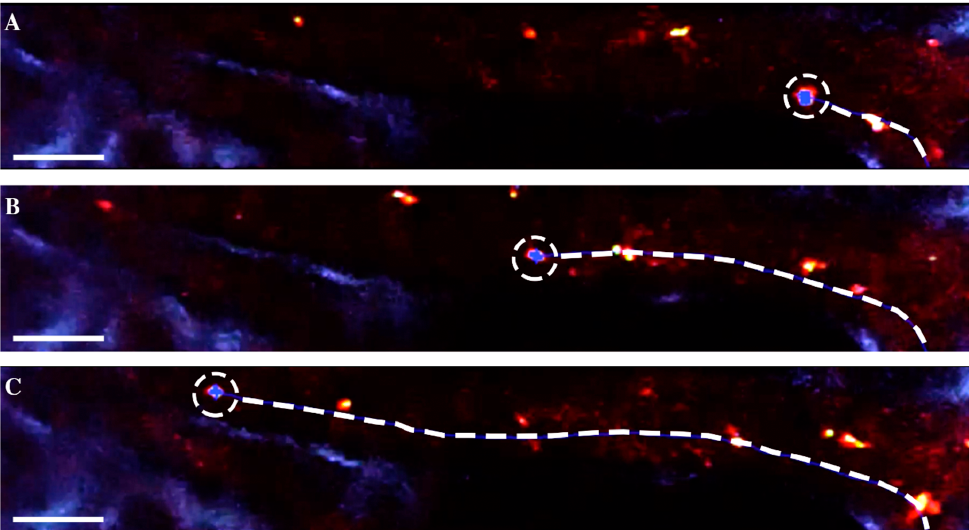
Figure 4. Sample particle tracking of an individual gold–silica nanoparticle within vasculature. ( A – C ) Nanoparticles are identified through the co-registration of luminescence in three imaging channels: 446, 525, and 575 nm. The nanoparticle is position tracked through the various frames of the video acquisition in white dashed circles, and blood velocity is recorded simultaneously.